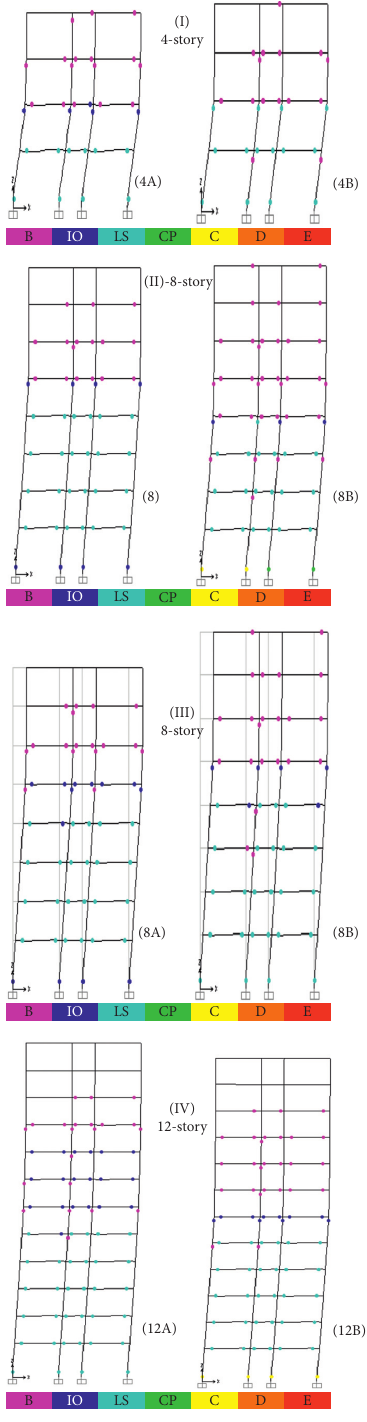
Figure 12: State of the plastic hinges in 4 (I-Uniform), 8 (II-Uniform, III-Uniform, and Mode 1), and 12 (III-Uniform): Left Model (A)-ES8- 15 and Right Model (B)-GB11-10 Model